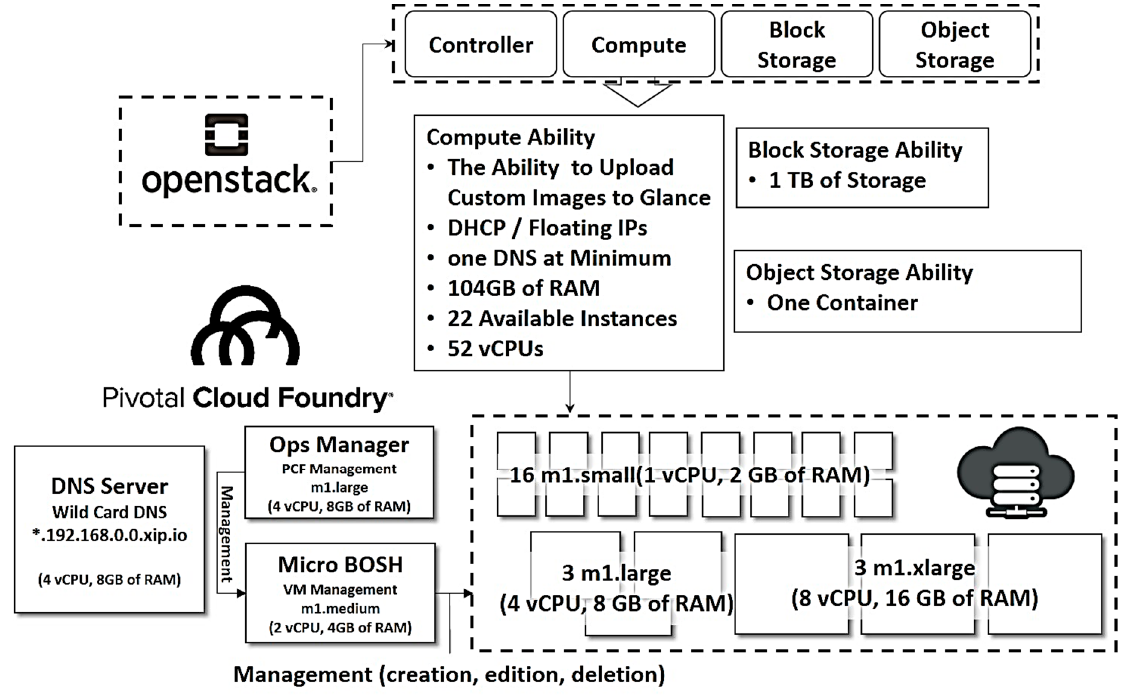
Figure 2. PaaS service implementation and instances using the open source of Cloud Foundry and OpenStack.